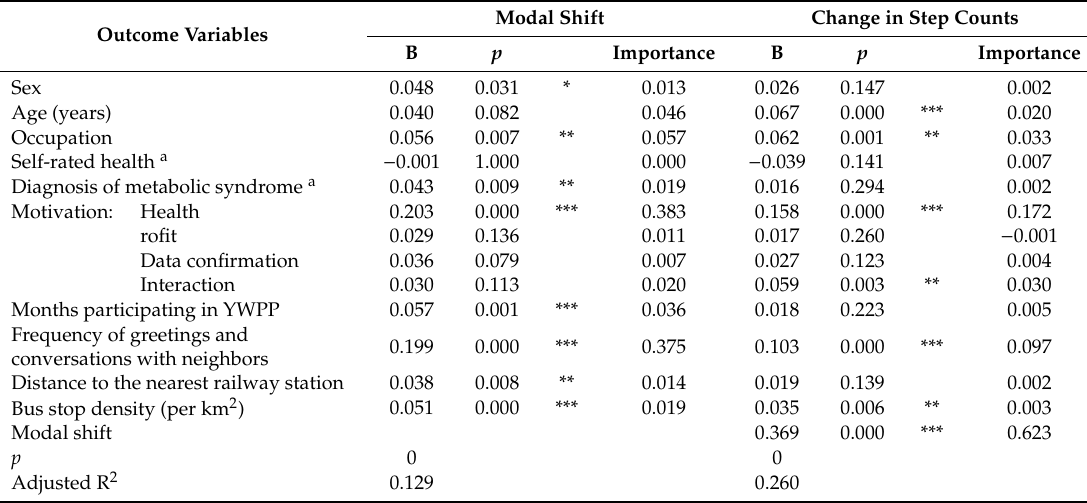
Table 2. Results of categorical